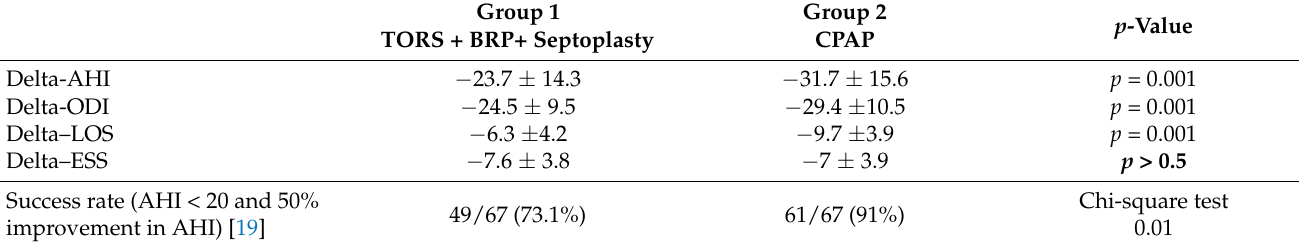
Table 5. Comparison between multilevel surgery and CPAP in post-treatment nocturnal